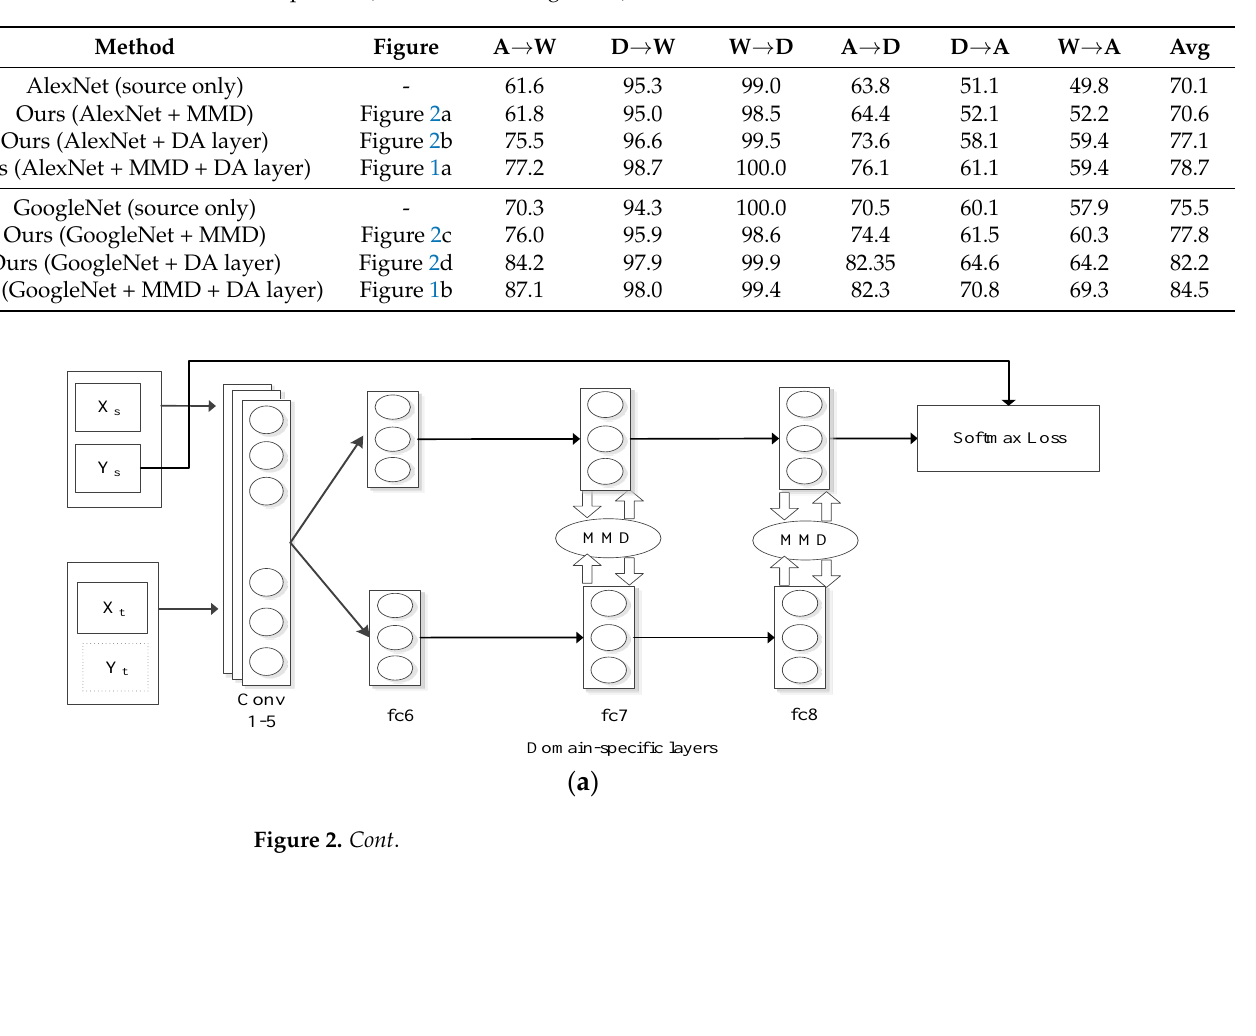
Table 4. Ablation study: classification accuracy (%) of the Office-31 dataset for unsupervised do- main adaptation (AlexNet and